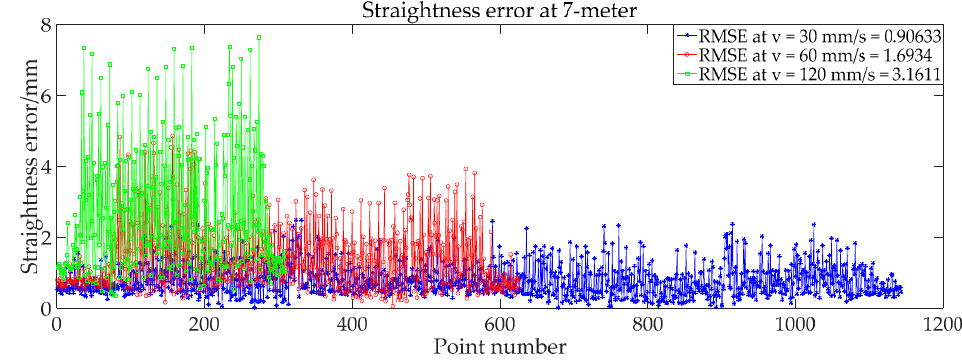
Figure 13. Straightness error of practical trajectory at 7-meter at different speeds.